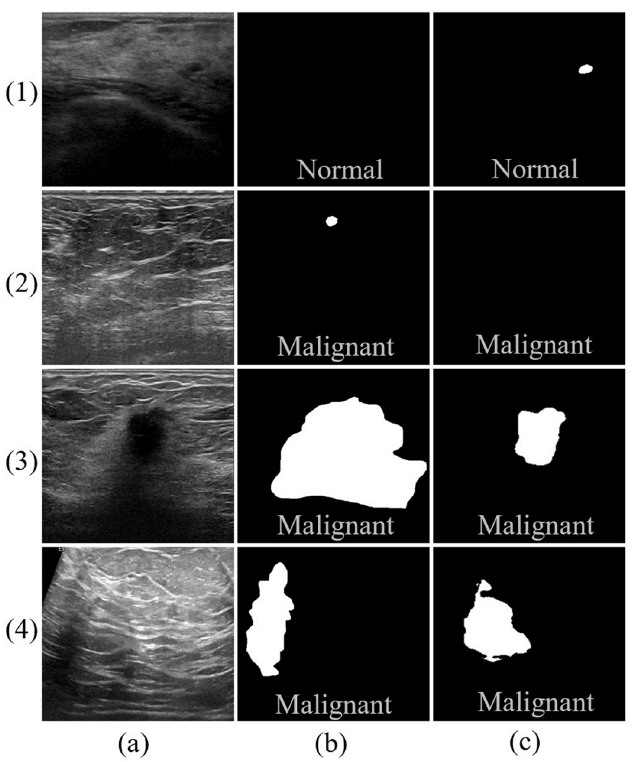
Fig 11. Illustration of segmentation failure examples. (a) BUS Images, (b) ground truth, (c) CTG-Net predictions. Image (1) is from the THH dataset, images (2) and (3) are from the UDIAT dataset, and image (4) is from the BUSI dataset. The text represents the category